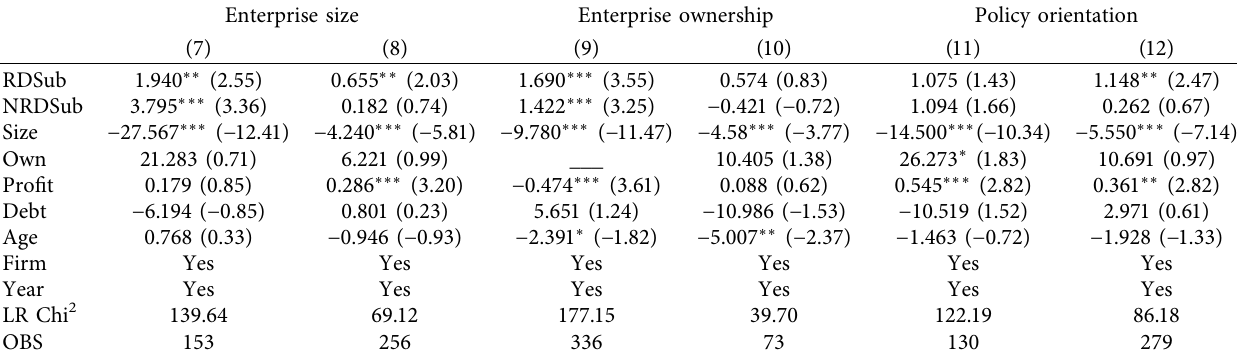
Table 6: Heterogeneity